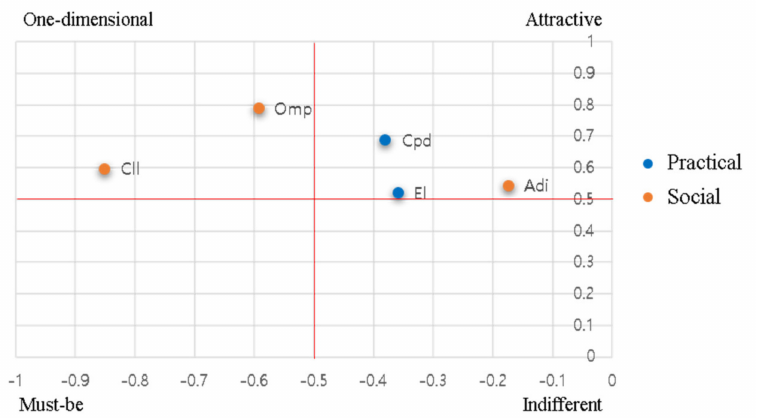
Figure 6. Factor positions for usable stage.